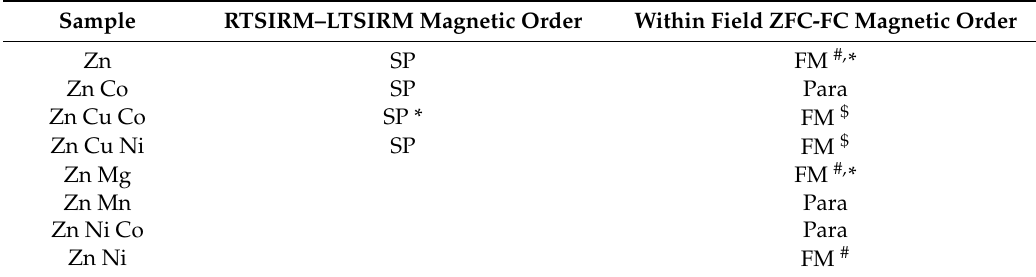
Table 4. Magnetic ordering behavior based on MPMS